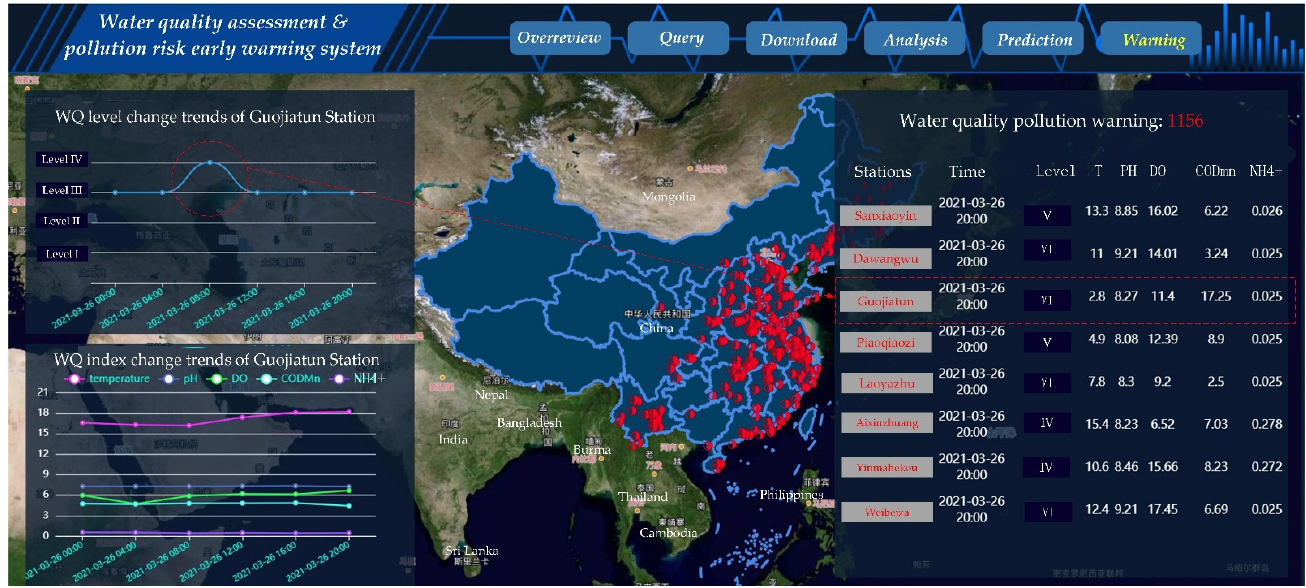
Figure 10. The water quality of pollution waring of prediction results.